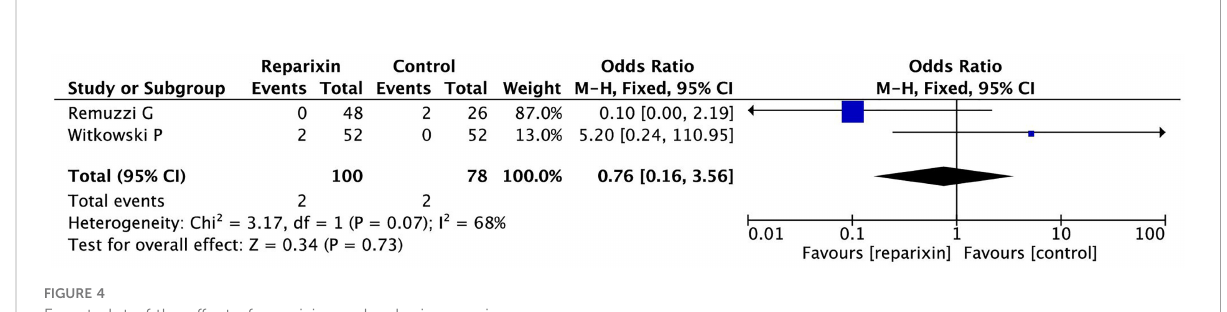
FIGURE 4 Forest plot of the effect of reparixin on developing sepsis.